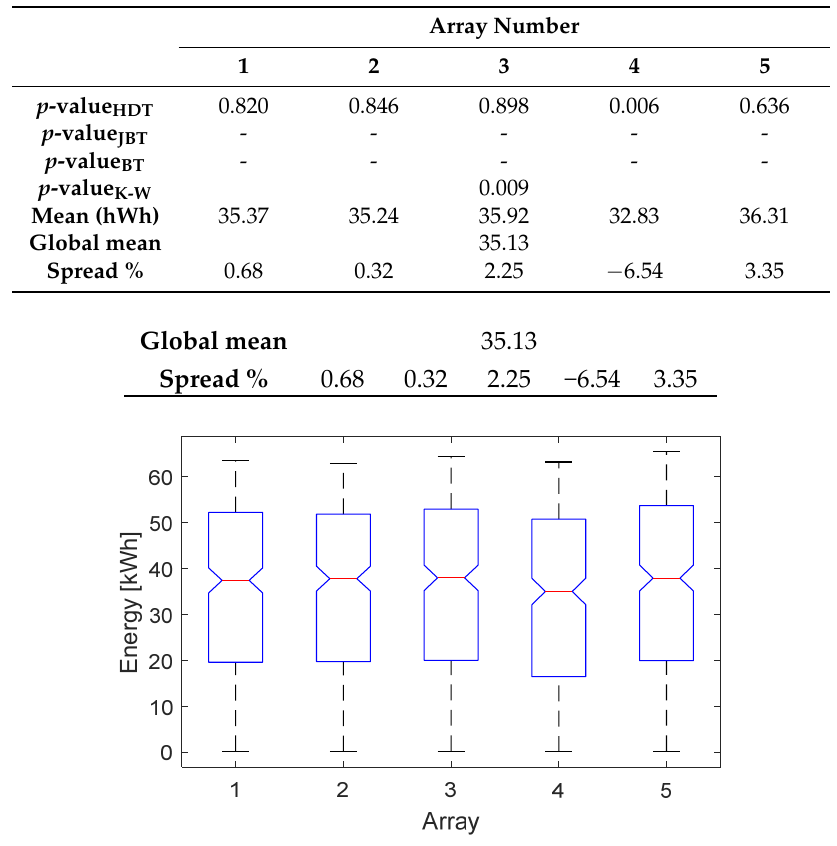
Table 7. p -Value of HDT and K-W for the energy distribution of the arrays, and mean in kWh and spread with respect to the global mean for one-year analysis.